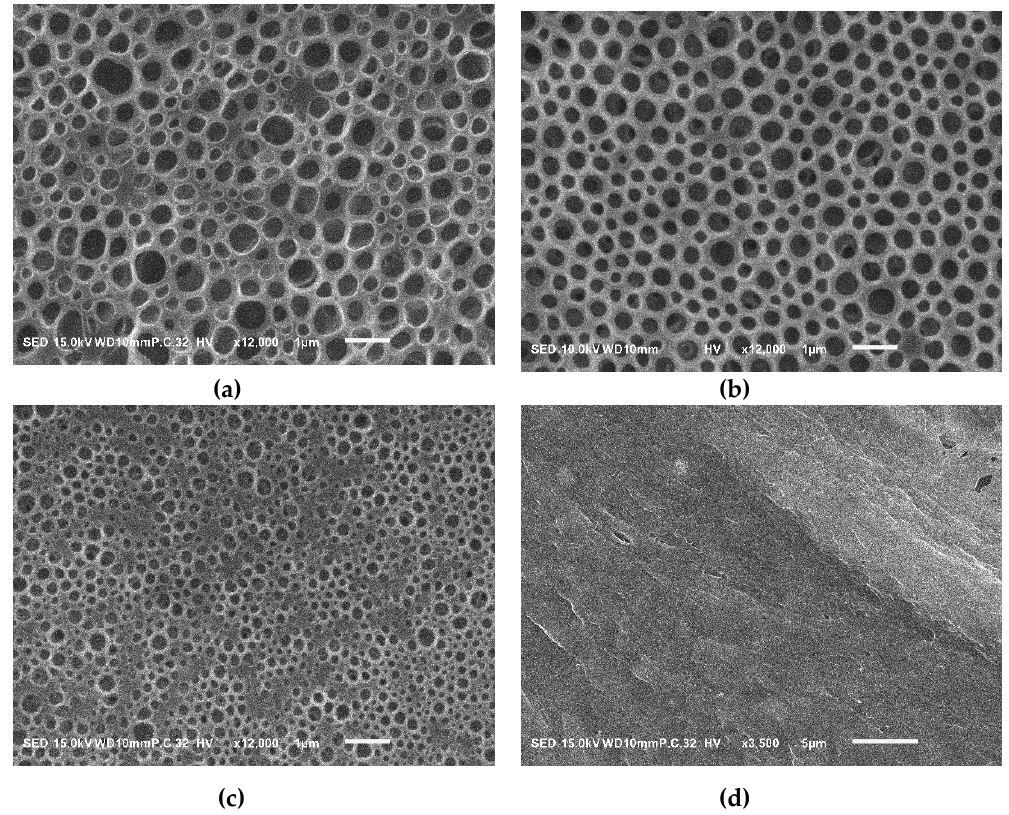
Figure 7. SEM images of BF films produced from deLG3-PSt 68k with different THF contents in the copolymer chloroform solution: ( a ) 10%; ( b ) 25%; ( c ) 50%; ( d ) 75%.